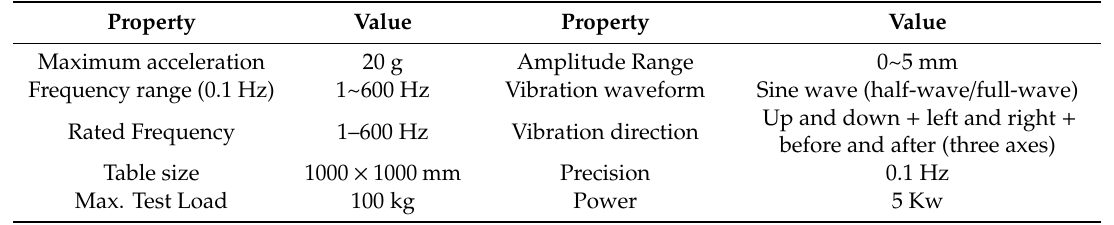
Figure 8. ZD / AB-XTP Vibration Test Bench. Figure 8. ZD/AB-XTP Vibration Test Bench. Table 2. Specifications of the vibration Table 2. Specifications of the vibration generator.